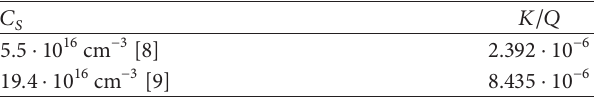
Table 3: Ratio 𝐾/𝑄 calculated from (47) and the data from Table 2. 𝐶